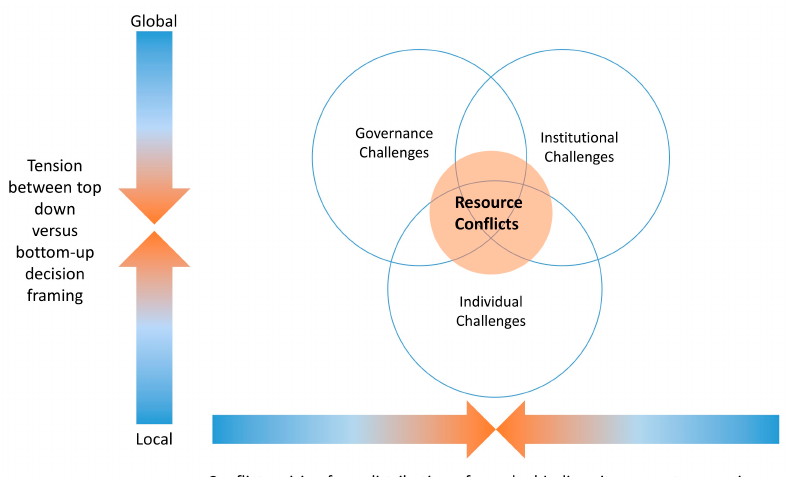
Figure 1. A simplified typology of some of the possible sources of conflicts in forests. The vertical axis represents the newly created pressures of international agreements that impact directly standing forests, afforestation, and reforestation programs. The horizontal axis represents the conflicts caused by the distribution of people (including property rights), the structure and composition of forests, and the different ecosystem services people are expecting to find. At the cross-roads of these vertical and horizontal dimensions, challenges arising from institutional factors, disputes in governance, and individual cognitive biases can collide, creating different conflicts at different scales. Transition policies (i.e., increased use of wood biomass for heating) often occur in a top-down fashion from national commitments and international agreements. Local knowledge would be related to the individual challenges regarding what management options are acceptable or not.